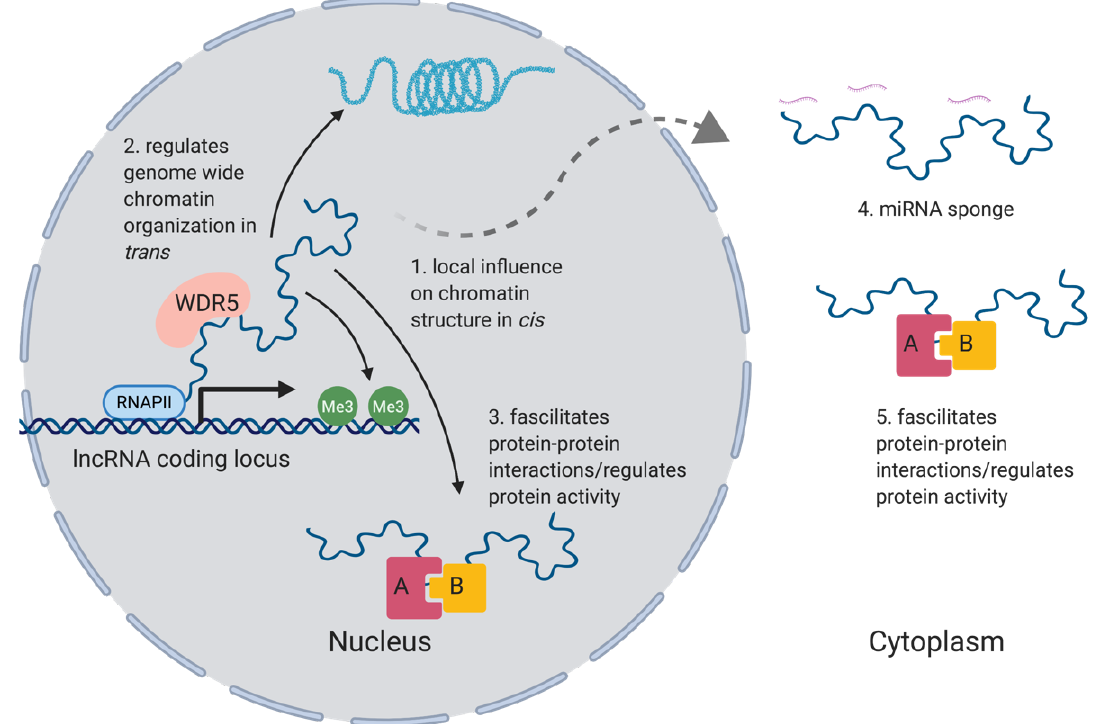
Figure 2. lncRNAs elicit their activity through a variety of mechanisms. As depicted, these may be nuclear or cytoplasmic in nature. WDR5 is shown to associate with the lncRNA as an example, but represents chromatin modifying enzymes in general. For more detailed descriptions of the molecular mechanisms by which lncRNAs function, we recommend [67].